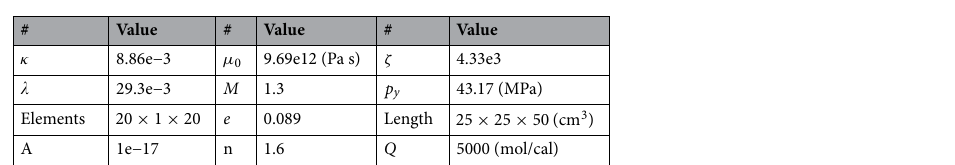
Table 2. Parameters employed in the cyclic loading for shale rock 46